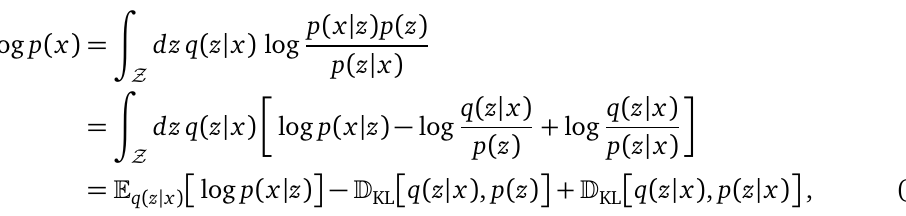
Figure 1: Visualization of a normalizing flow architecture. The forward direction starts with a sample z distributed according to the base distribution p ( z 0 n flow bijections f are applied to arrive at z i from x , the flow transforms are applied in reverse order to arrive at z ) can be p ( z 0